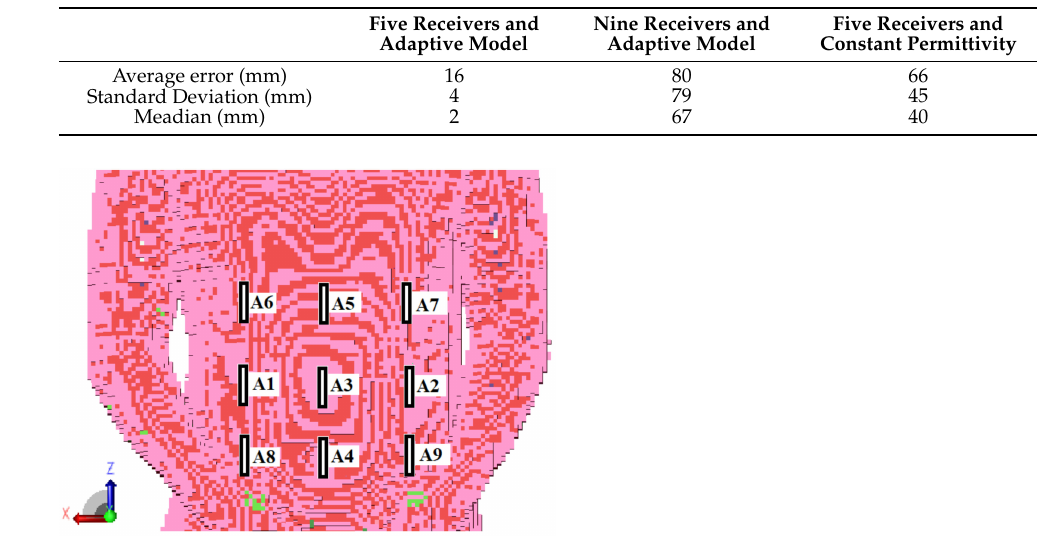
Figure 7. External receivers arrangement used to investigate the impact of the number of receivers on the accuracy of the location.